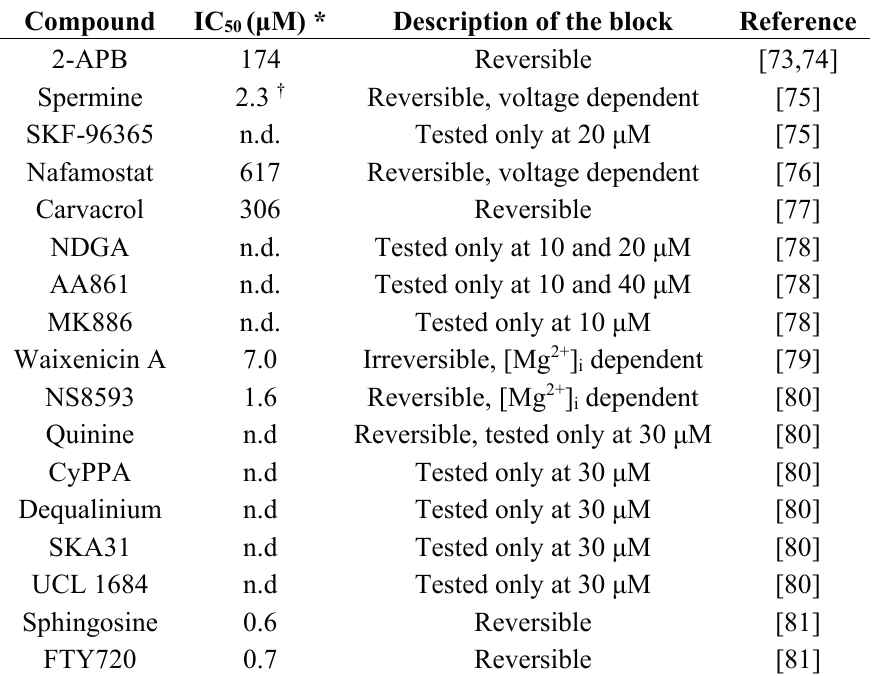
* IC 50 values were shown for recombinant TRPM7 currents measured in the absence of internal Mg 2+ . † The dose-dependent effect of spermine was evaluated on endogenous TRPM7 currents in divalent-free external solution. n.d. - not